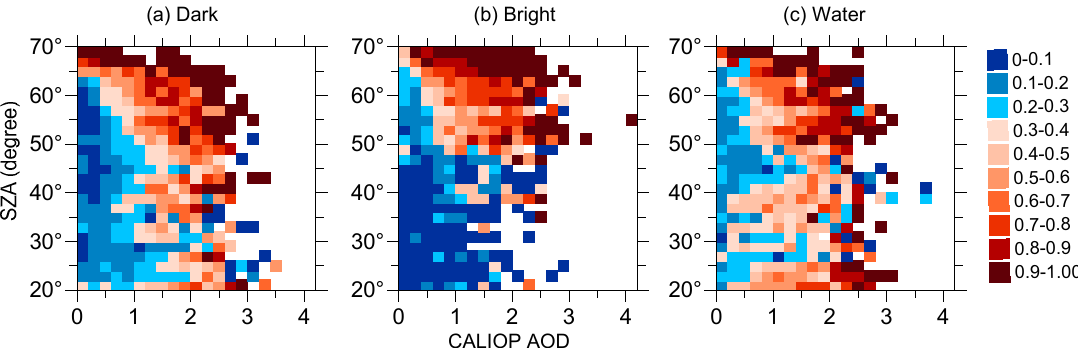
Figure 4. Dependence of r_MODcloud_CALfree on aerosol optical depth (AOD) and solar zenith angle (SZA) over ( a ) dark; ( b ) bright; and ( c ) water surfaces.